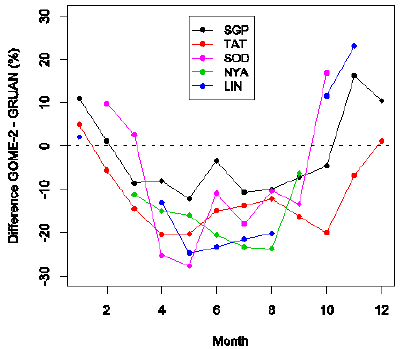
Figure 3. Monthly averages of the differences between TWVC data retrieved by GOME-2 and GRUAN sounding data (Eq. 3) for five out of six GRUAN sites used in this